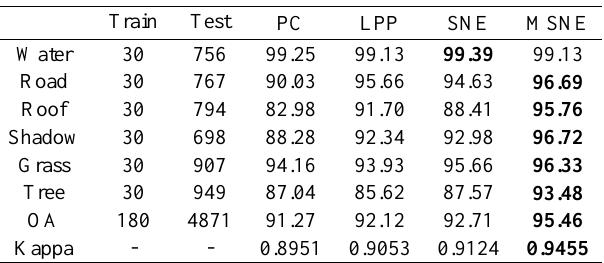
Fig.3. (a)-(d) Classification maps of Pavia city data set obtained using features of PCA, LPP, SNE, and MSNE, respectively. Four different feature based classification results are compared in Figs. 3 (a)-(d). In all dimensional reduction methods, the size of reduced feature space is fixed at 25. In Fig. 3, the proposed MSNE based classification achieved the best performance. Compared to the other three dimension reduction methods in Figs. 3(a), (b) and (c), the proposed MSNE shows a good classification result. In order to evaluate thoroughly the different feature representations, the averaged